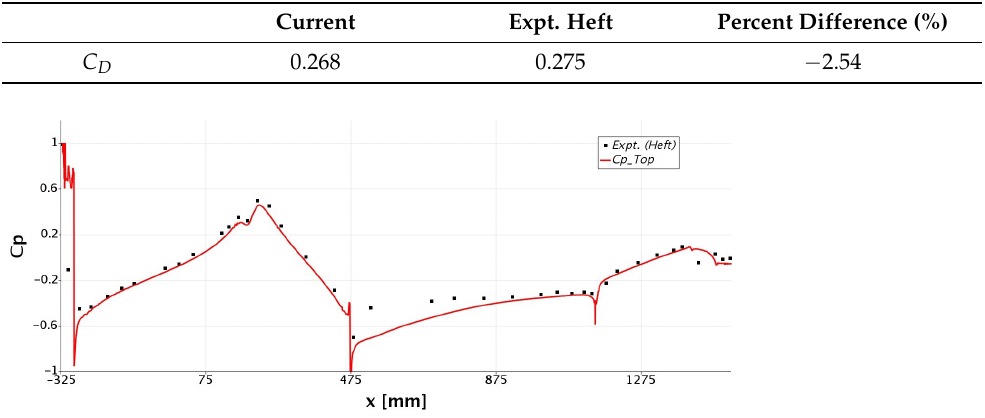
Figure 12. C p Over the Top of the Isolated DrivAer Fastback Simulation versus Experimental